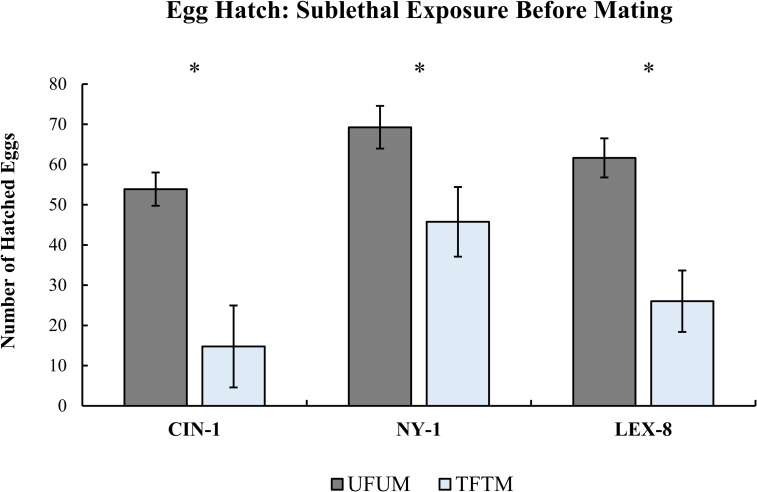
Characterization of the number of eggs hatched when sublethal exposure occurred before mate pairing.This experiment partially replicates the first fecundity test, but starts with males and females that had no previous contact with the other sex. There was significant reduction in the number of hatched eggs for every strain. Hatching decreased by 73%, 34%, and 58% for CIN-1, NY-1, and LEX-8, respectively, when both the male and female in the mating pair had sublethal exposure (LT10) to the label rate of Temprid SC prior to mating (Paired t-test, CIN-1: T = 3.59, df = 7, p<0.01; NY-1: T = 2.78, df = 7, p<0.05; LEX-8: T = 3.89, df = 7, p<0.01). Asterisks denote statistical significance (*p<0.05).